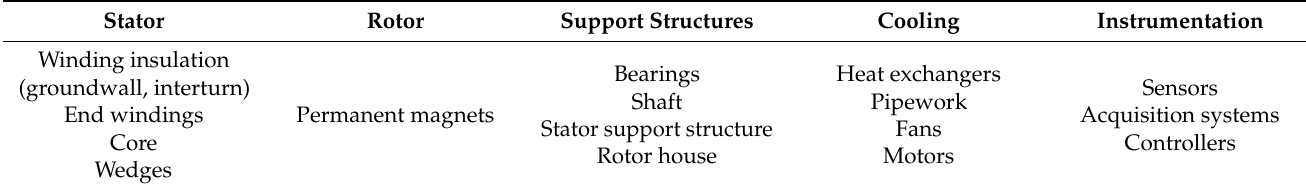
Table 1. List of components prone to fail in a DD